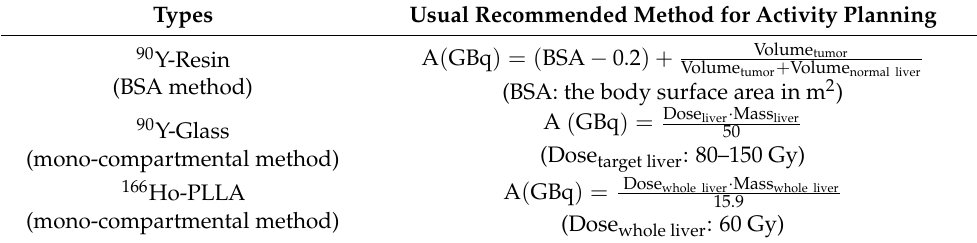
Table 3. Activity